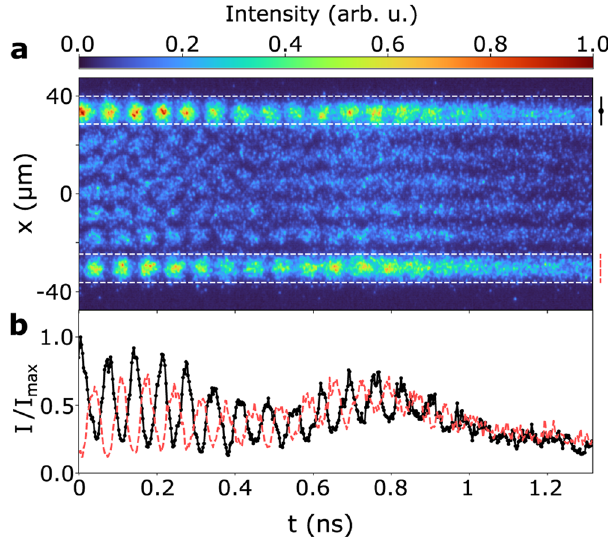
Fig. 6 Coherent oscillation under imbalanced optical pumping of the direct coupler. a Streak camera image of the direct coupler with off-center pumping of a single condensate (compared to the con fi ning potential). b Integrated intensity of the individual condensate sites. An oscillation is present with a frequency of (14.5 ± 0.5) GHz resulting from the coherent superposition of the antisymmetric state (with 6 nodes) and the symmetric state (with 5 nodes). The oscillation is damped as the system evolves from a superposition of both states into the single lower-energy antisymmetric